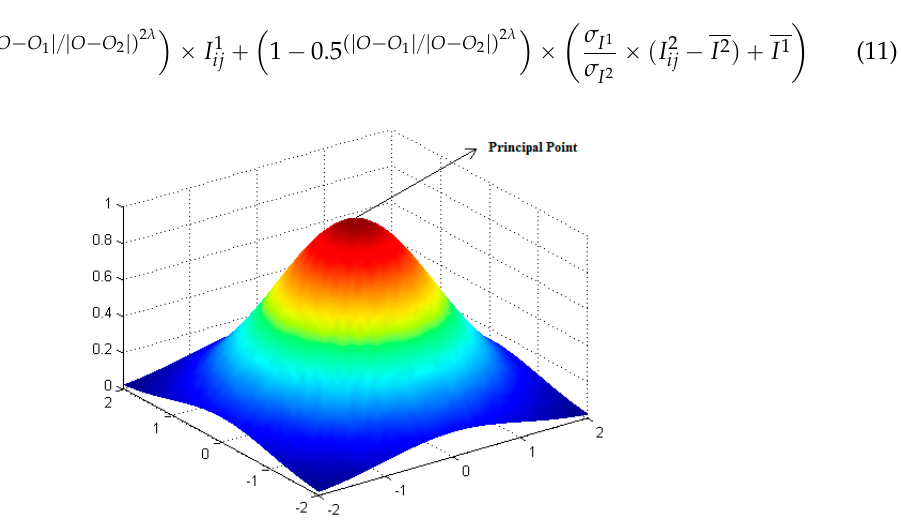
Figure 1. An example of a two-dimensional Gaussians distance weight distribution kernel.